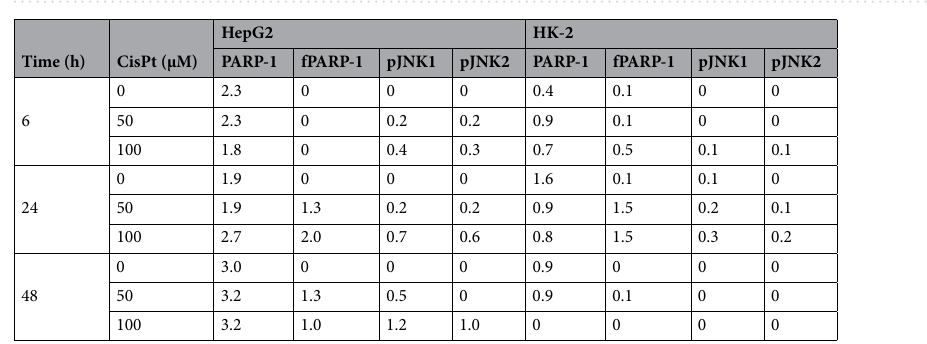
Figure 4. Caspase 3/7 activity in CisPt treated cells. HepG2 ( A ) and HK-2 ( B ) cells were treated with CisPt (50 and 100 µM) for 6, 24 and 48 h. After incubation, the activity of caspases 3/7 was measured (EX/ EM = 485/535 nm). Data are presented as mean ± SEM (n = 2). (* p < 0.05; ** p < 0.01; *** p < 0.001; vs. untreated cells at appropriate time interval).